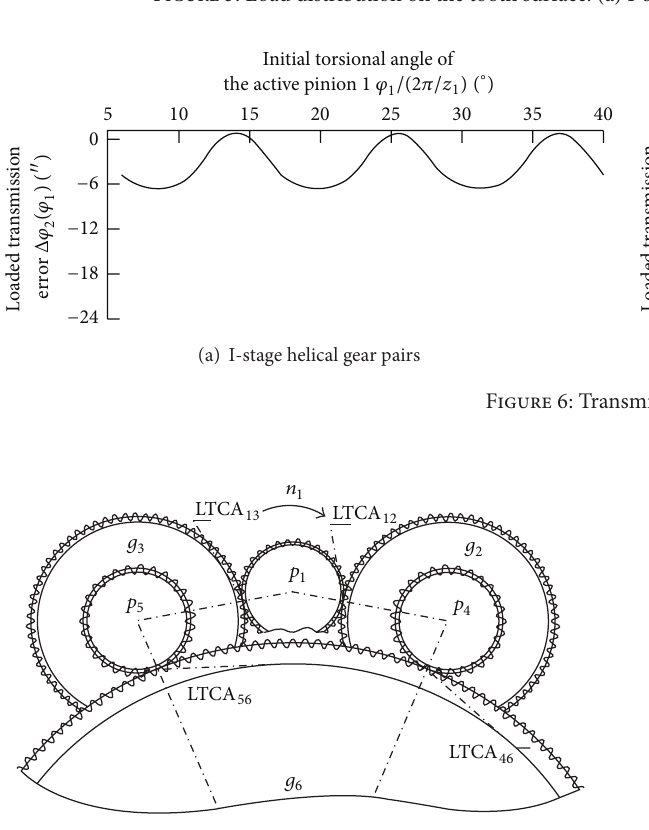
Figure 7: The whole system LTCA model.